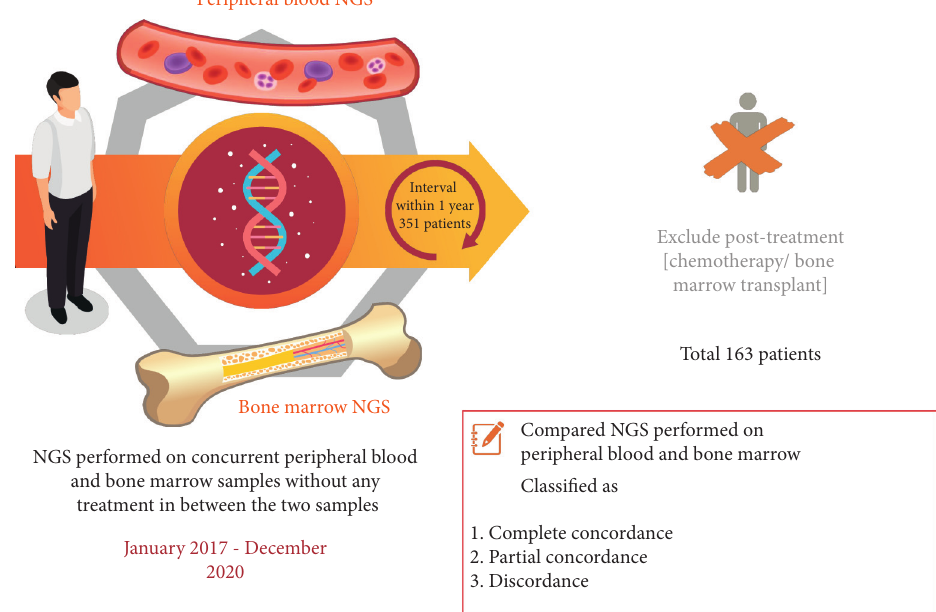
Figure 1: Diagram showing the selection of the study population.